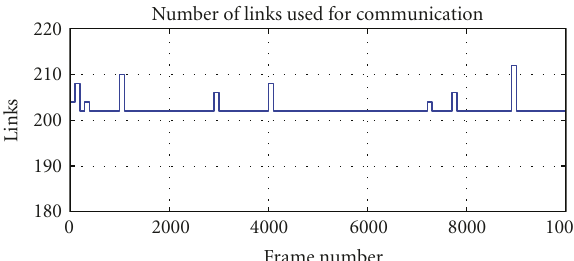
Figure 18: Number of active links in the network for implemented Steiner tree.